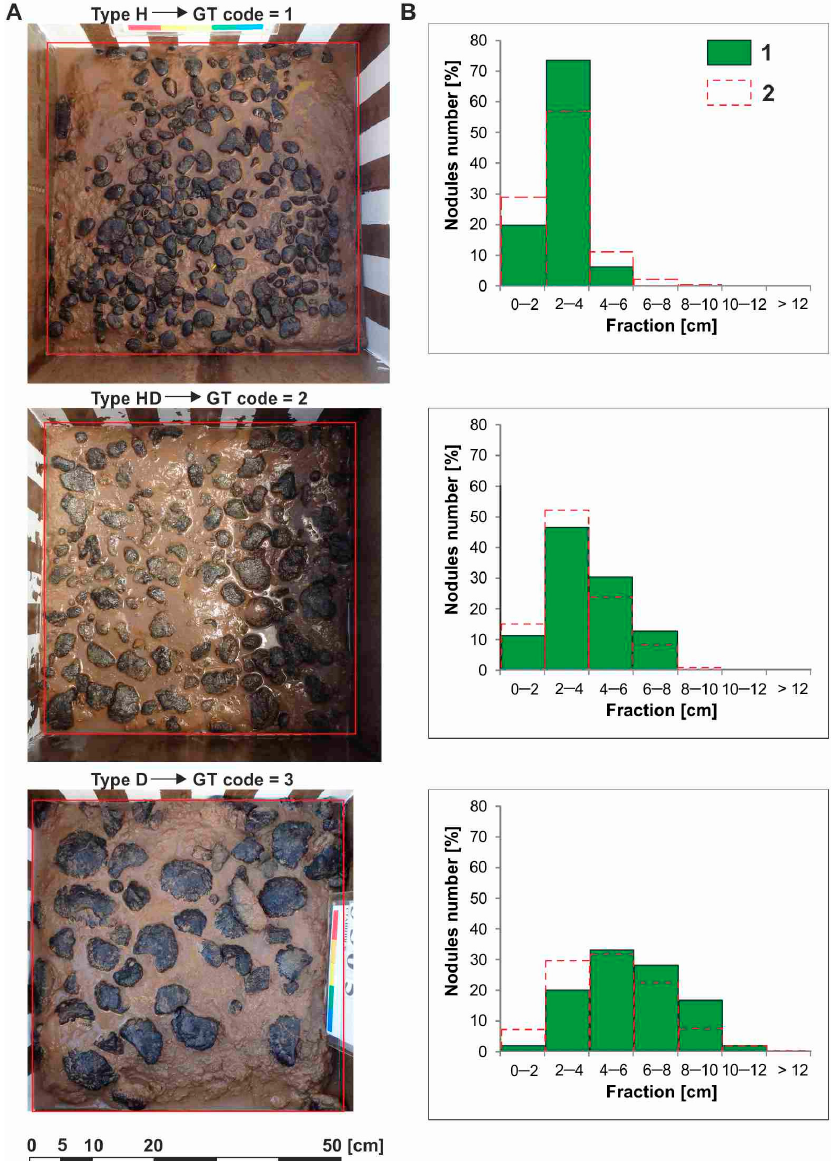
Figure 5. Examples of box corer photographs for three genetic types of nodules ( A ); fraction distributions of the nodules defined based on the presented (on the left) box core samples (1—green bars) and the mean number of nodules in the fractions based on the box core samples from H22 exploration block (2—dashed red line) ( B ).